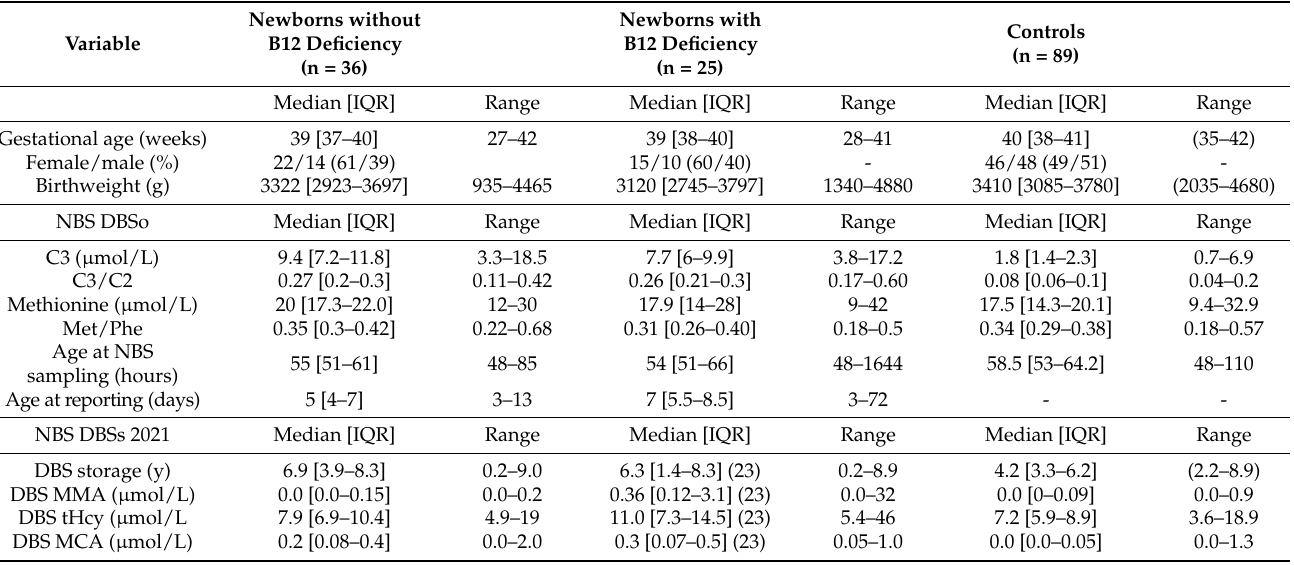
Table 2. Newborn screening data in cases reported with false positive results for methylmalonic acidemia and propionic acidemia (n = 61) categorized with and without B12 deficiency and 89 DBS controls. Numbers are given with median, interquartile range and range. The number in parenthesis is the number of cases with available